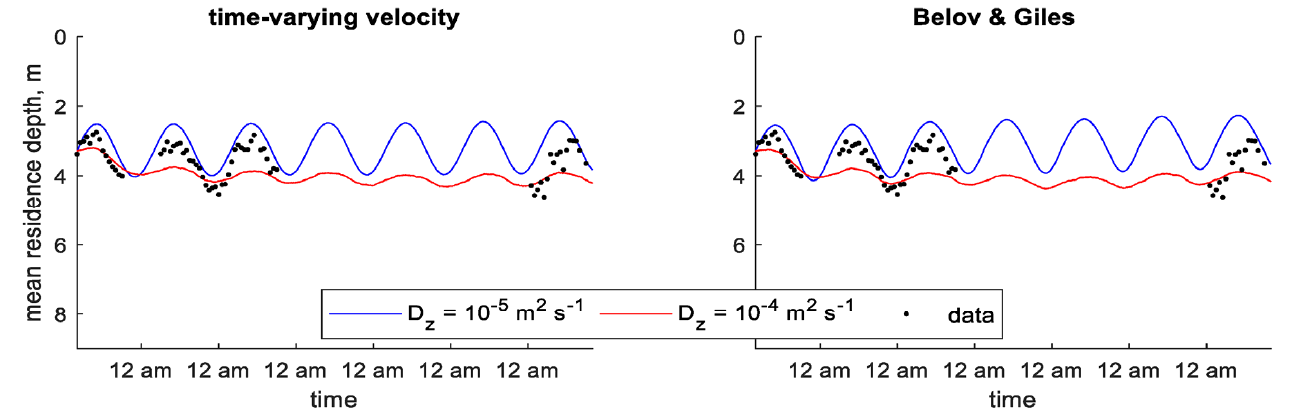
Figure 8. Time series of observed and predicted mean residence depth of chlorophyll a concentration in Xiangxi Bay using predefined velocity models (particle-tracking)